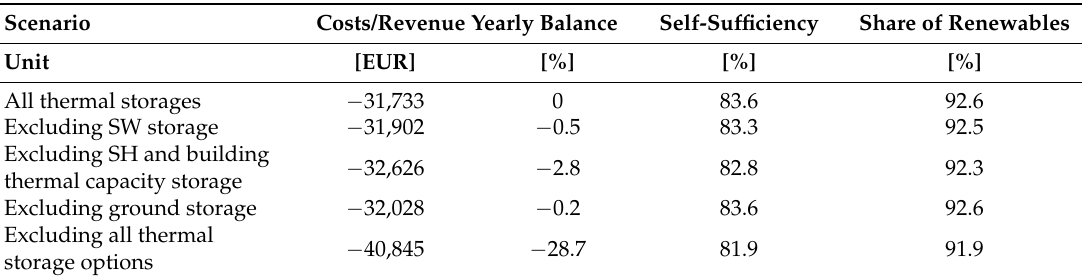
Table 2. Sensitivity of yearly profitability, self-sufficiency, and share of renewables depending on thermal